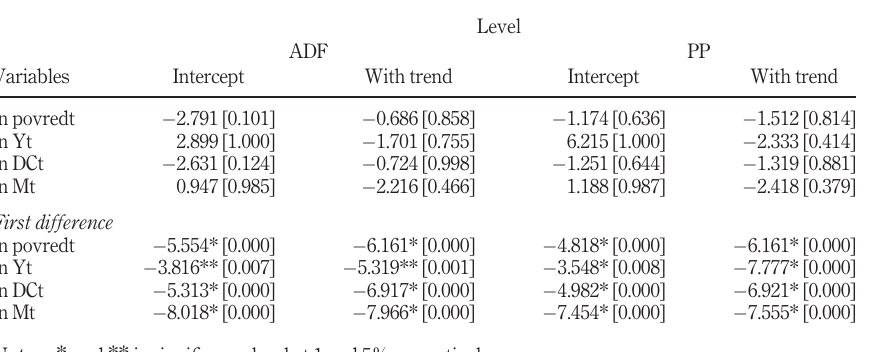
Table I. Unit root